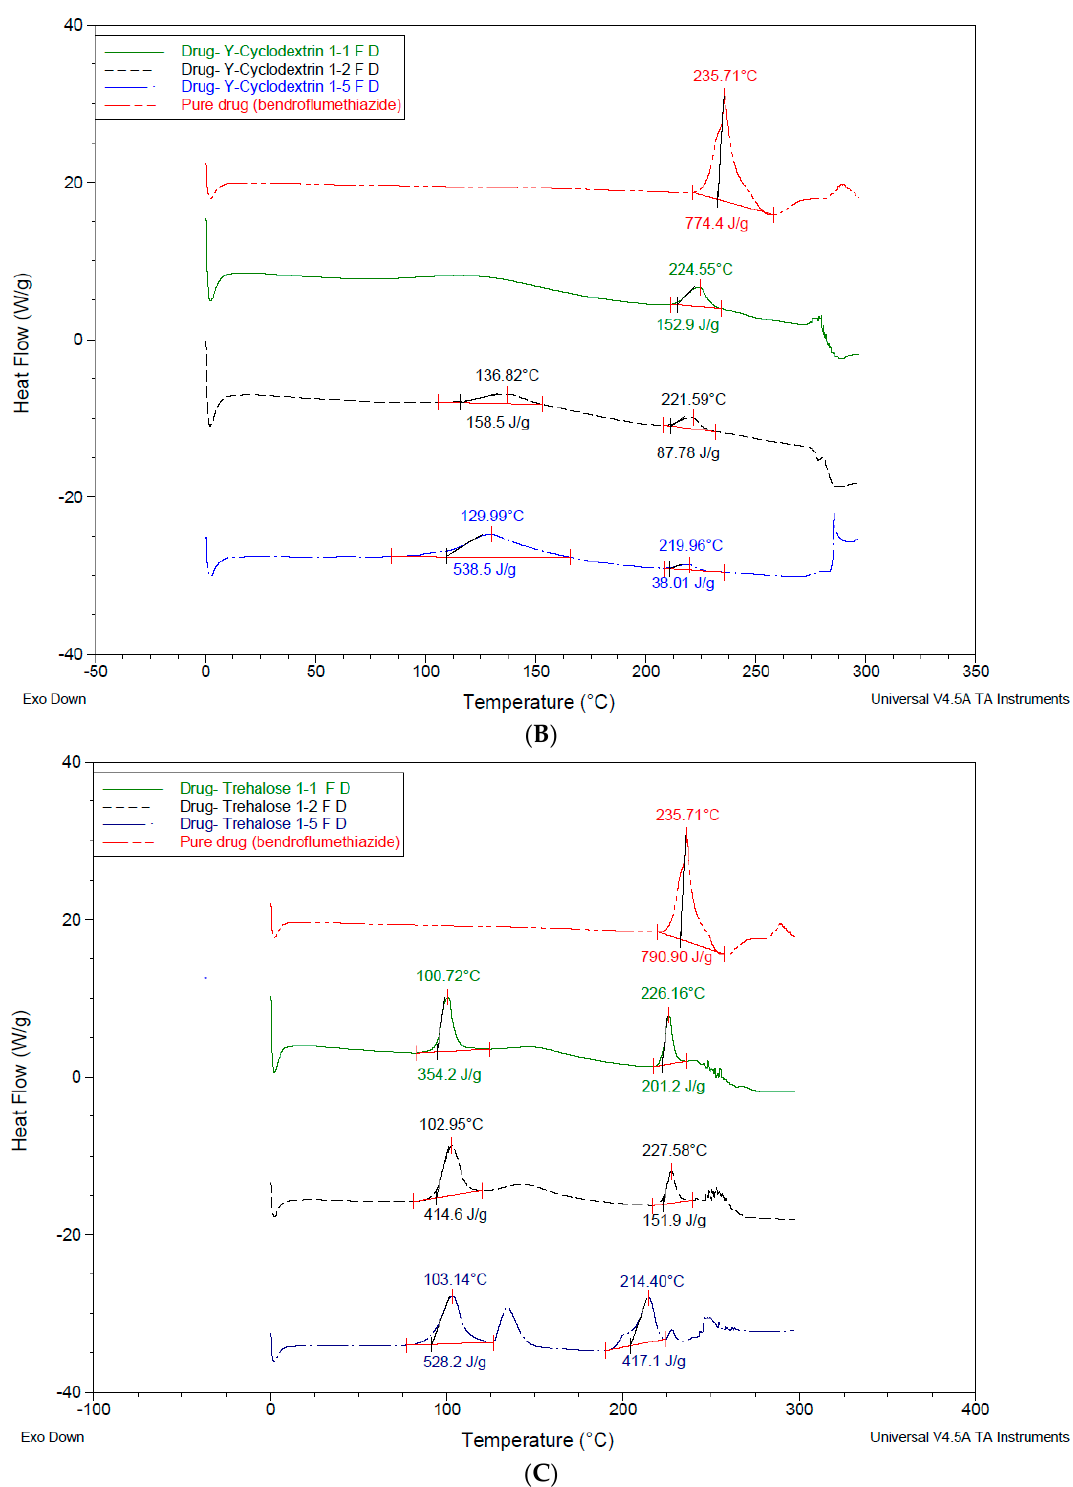
Figure 8. DSC data for lyophilised drug with excipients. ( A ) DSC for drug-gluconolactone after freeze drying; ( B ) DSC for drug-hydroxyl propyl γ -cyclodextrin after freeze drying; ( C ) DSC for drug-trehalose after freeze drying.